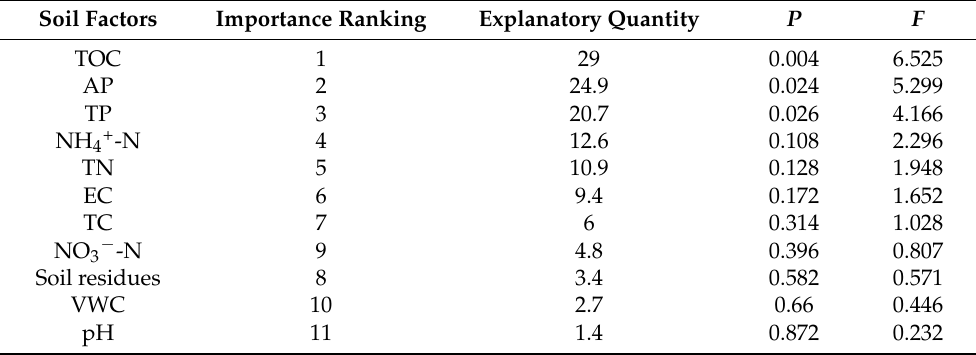
Table 5. Importance ranking and significance of soil factors in their explanation of the overall bacterial dominant communities in all soils. Soil